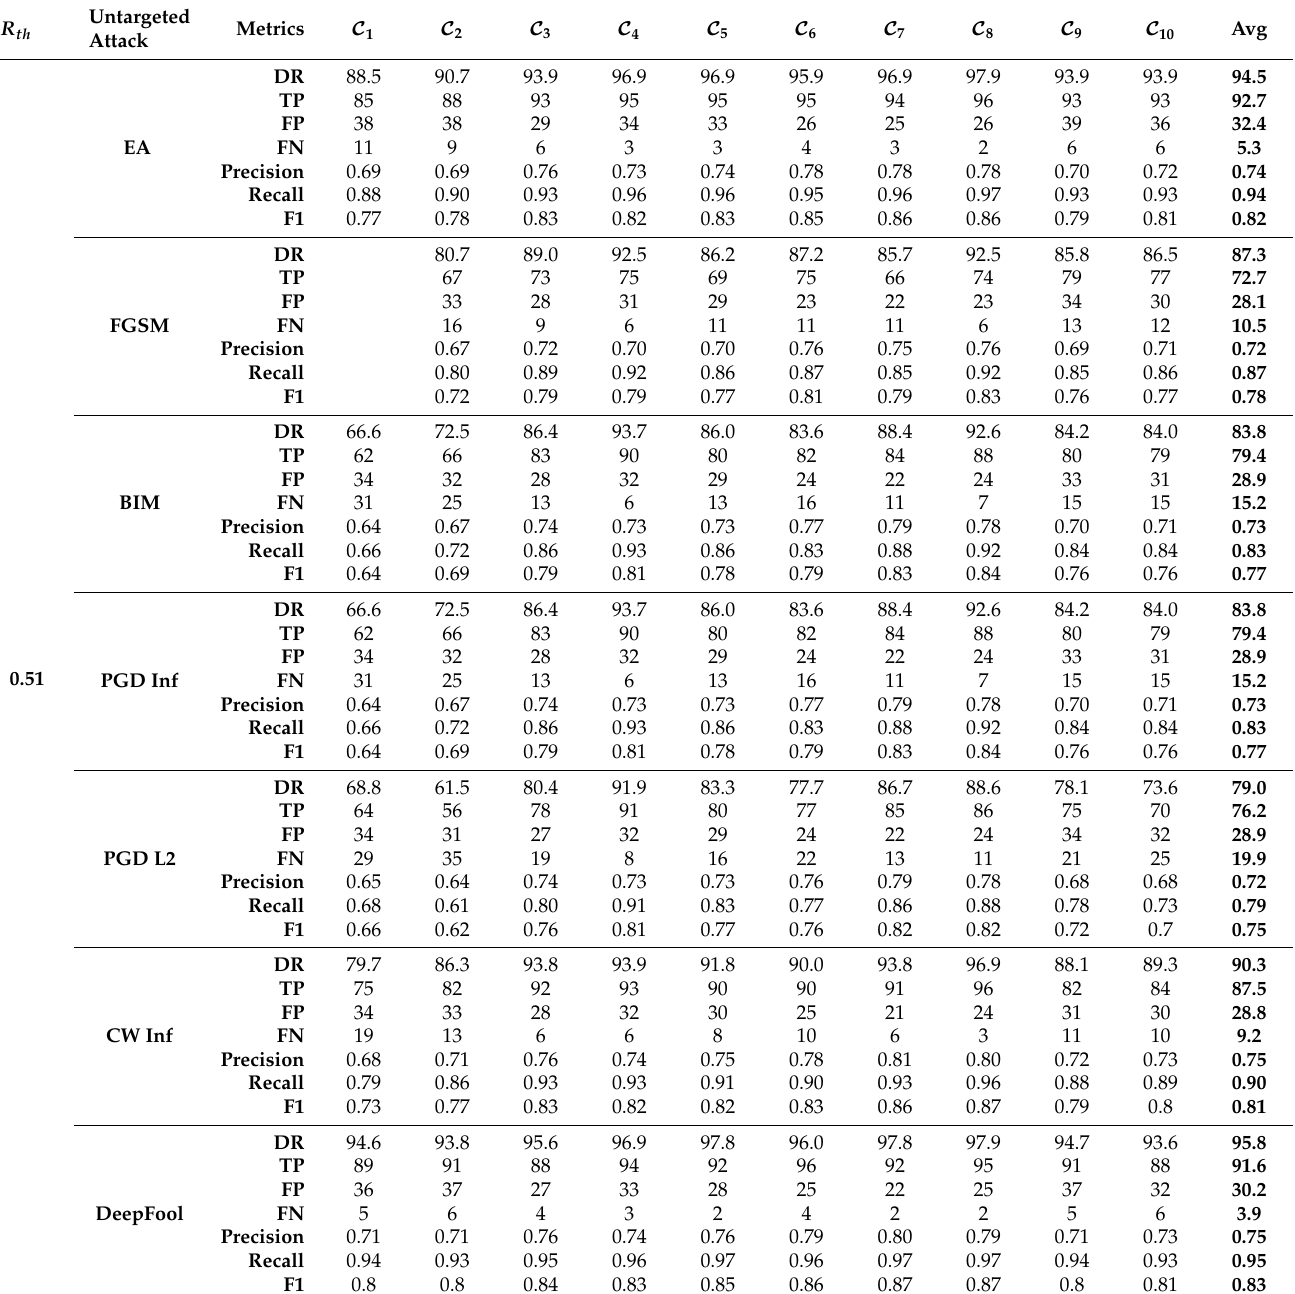
Table 11. Untargeted attacks—DR as a percentage, and TP, FP, FN, precision, recall, F1 scores per CNN per attack for each selected value of R th = 0.51, and their corresponding